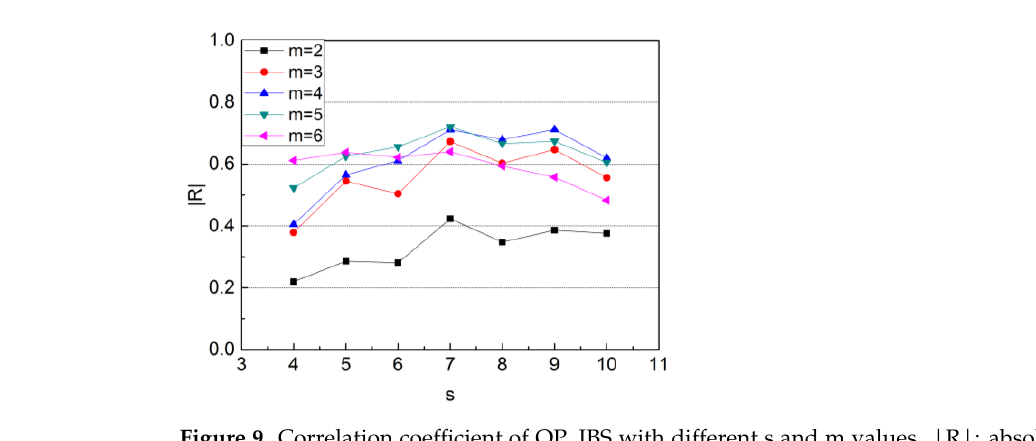
Figure 9. Correlation coefficient of OP_IBS with different s and m values. |R|: absolute value of correlation coefficient.